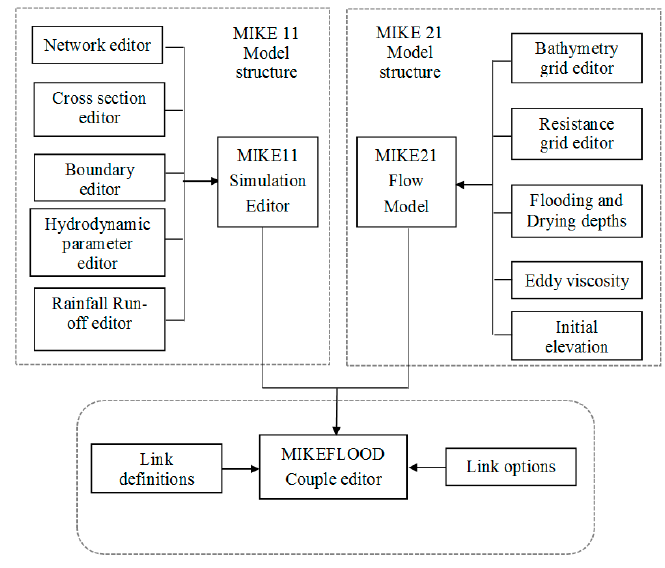
Figure 6. Schematic diagram of the model structure.